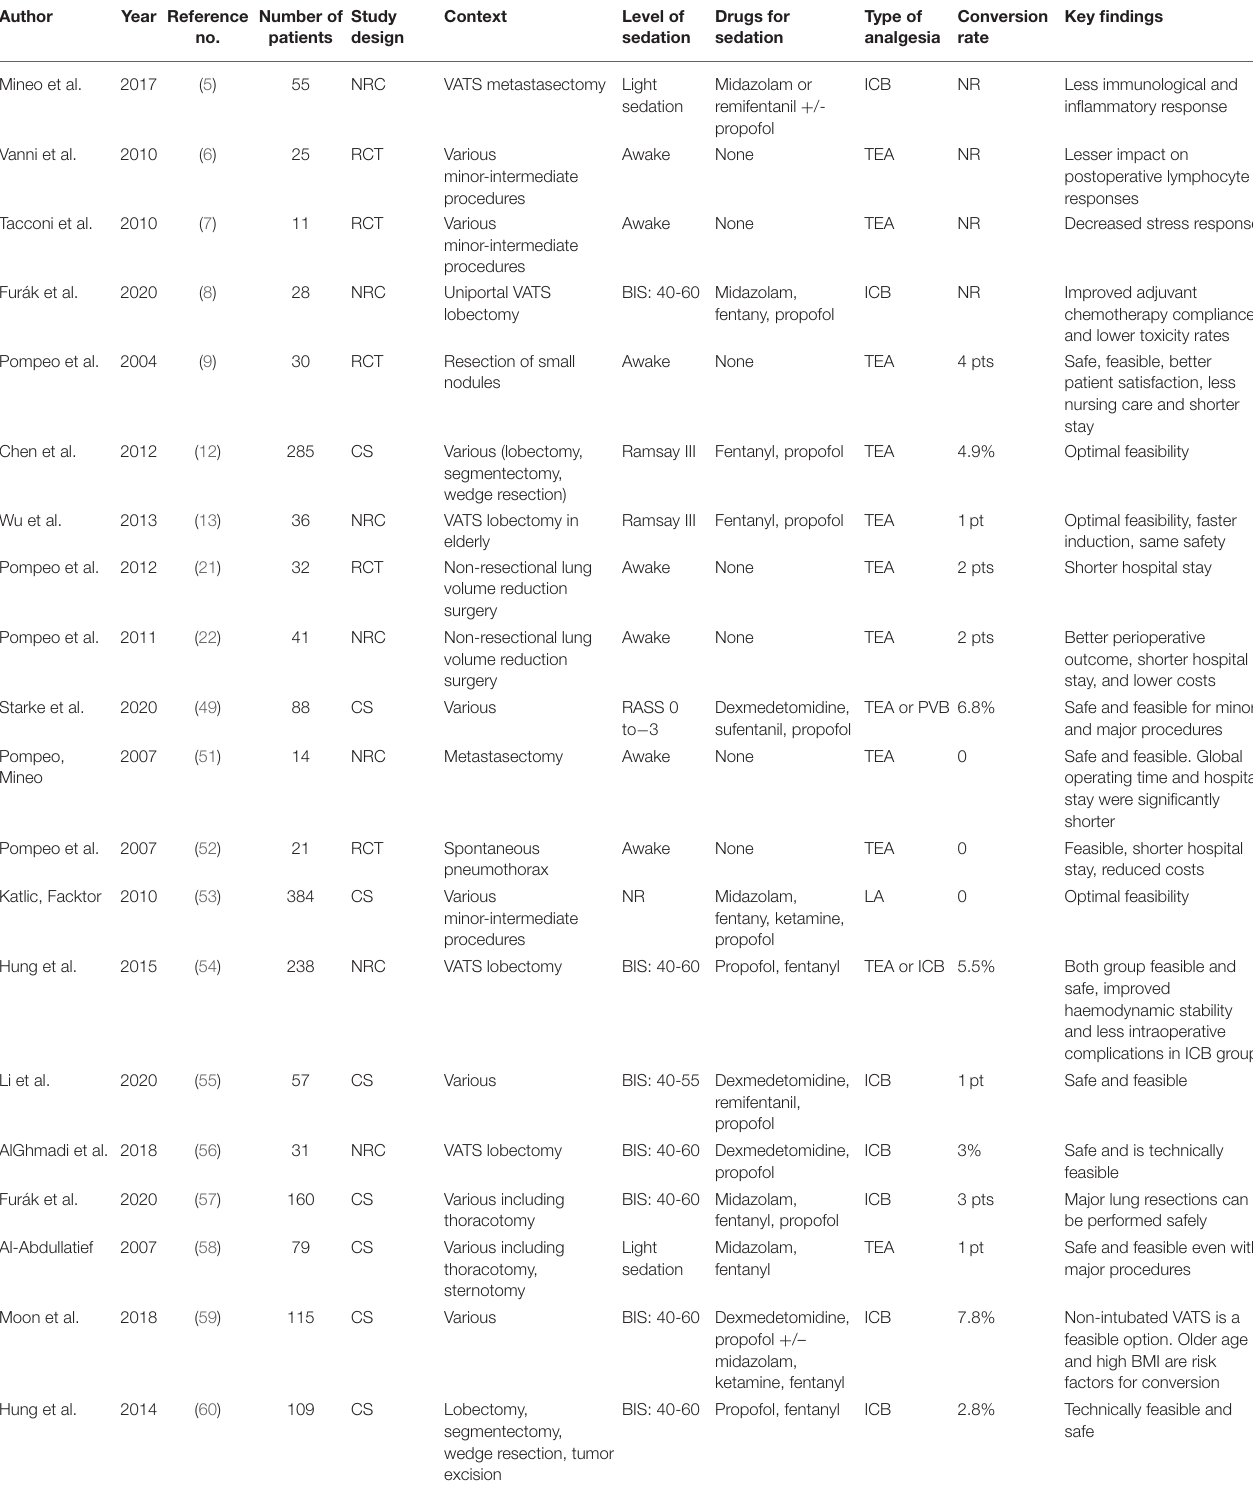
TABLE 1 | Characteristics and key findings from most relevant articles on non- intubated